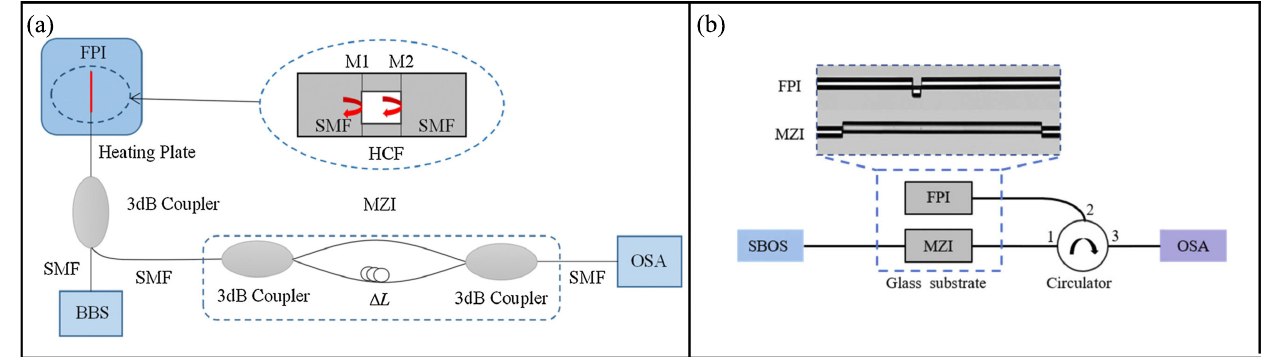
Figure 12. Vernier effect fiber sensors based on hybrid configurations (MZI and FPI), ( a ) the FPI is fabricated by splicing a segment of HCF between SMFs, and the MZI is formed by two 3 dB couplers [72], ( b ) both the FPI and MZI were made up of core-offset structures [73]. Reprinted with permission from Ref. [72] ©Elsevier. Reprinted with permission from Ref. [73] ©The Optical